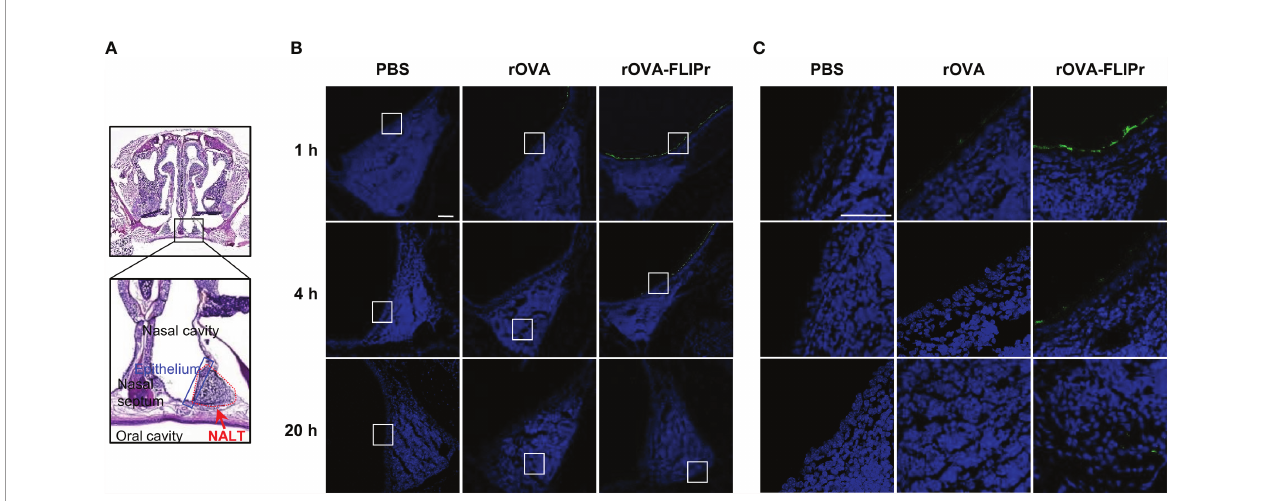
FIGURE 1 | Ovalbumin fusion with FLIPr increases the deposition of ovalbumin on the nasal epithelium via intranasal administration. (A) Schematic position of NALT. Nasal cavity staining with hematoxylin and eosin. The red dotted line indicates the range of NALT, and the blue line indicates the epithelial layer that covers NALT. (B) PBS (left panel), rOVA (middle panel) or rOVA-FLIPr (right panel) was intranasally administered, and the nasal cavity was collected at the indicated time points. Antigen staining (green) in NALT was performed using an anti-His tag antibody following the Alexa Fluor ® 488-conjugated secondary antibody. Images were obtained from single optical sections acquired by means of confocal microscopy (40× total magni fi cation, Scale bar = 100 µm). (C) The enlarged fi eld of the white box from (B) (40× total magni fi cation, Scale bar = 40 µm). Experiments were repeated twice with similar